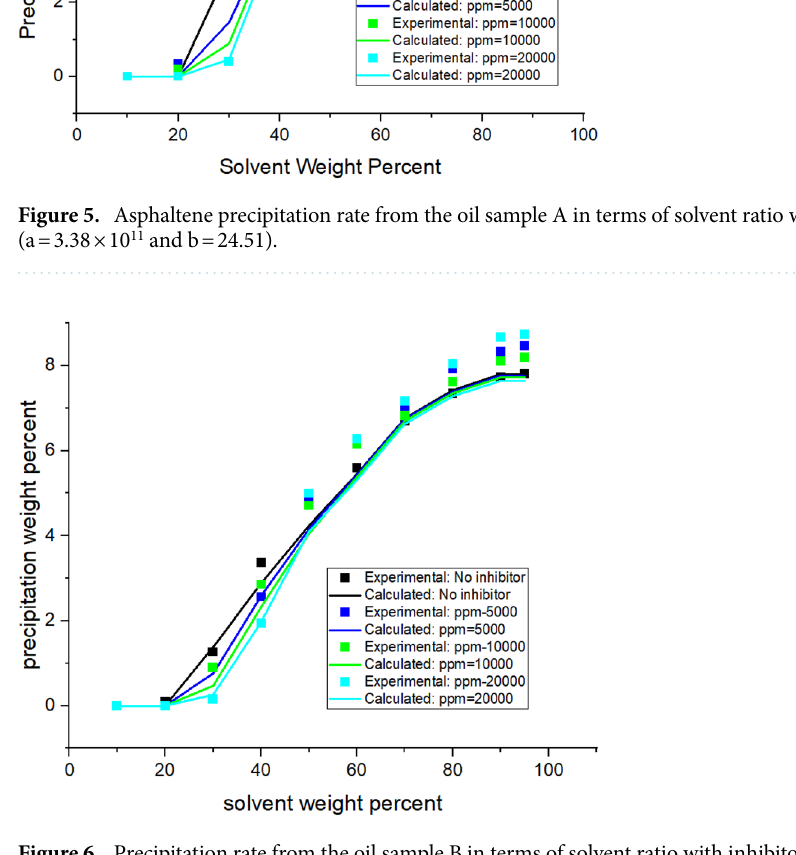
Figure 6. Precipitation rate from the oil sample B in terms of solvent ratio with inhibitor (a = 4.29 × 10 8 and b =